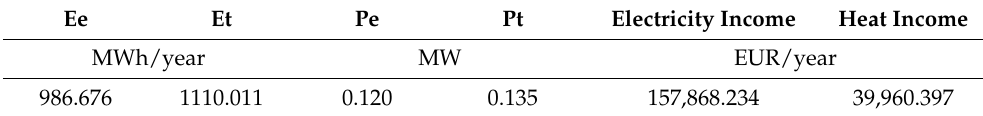
Table 7. Energetic and economic calculations of produced methane.